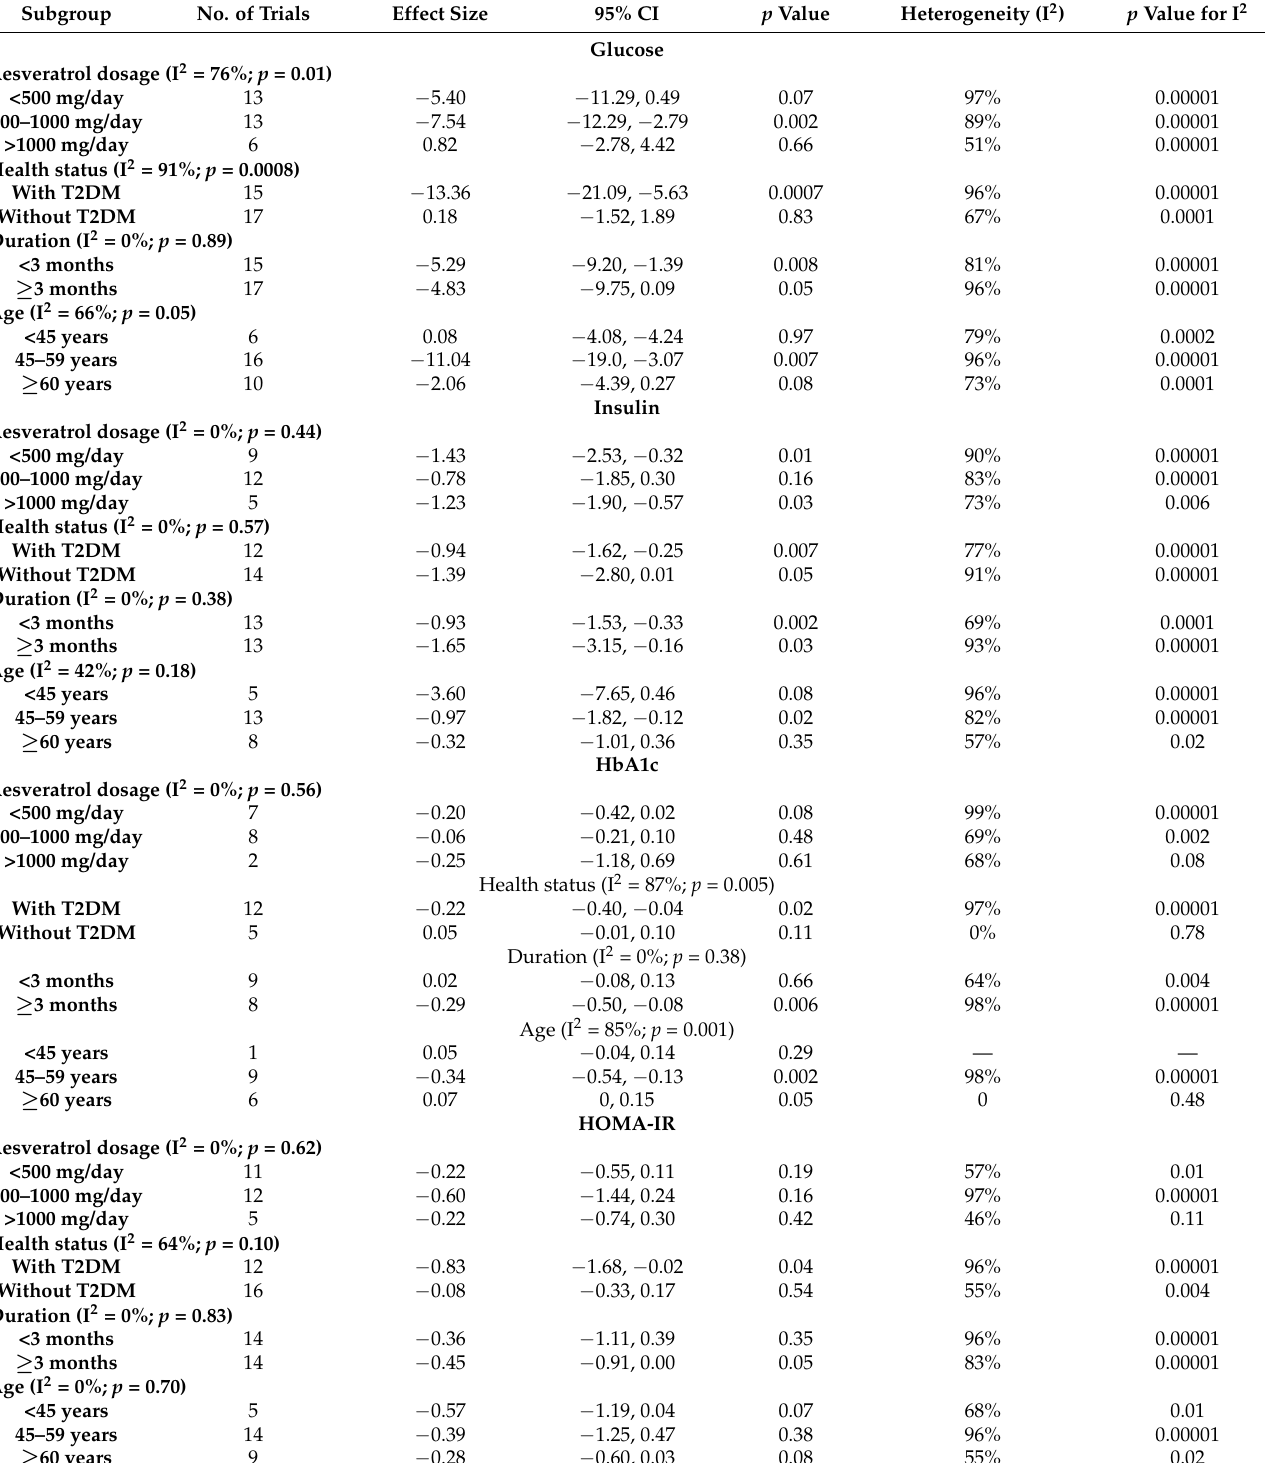
Table 2. Subgroup analysis conducted to evaluate the hypoglycemic effect of